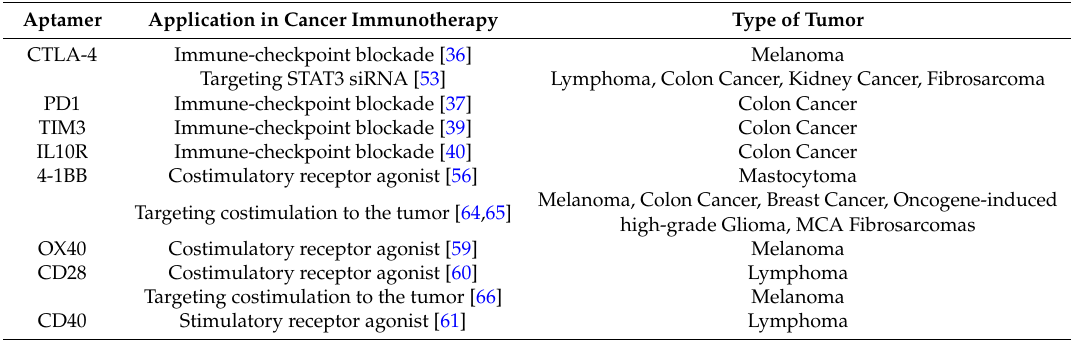
Table 1. List of immunomodulatory aptamers described in cancer immunotherapy.